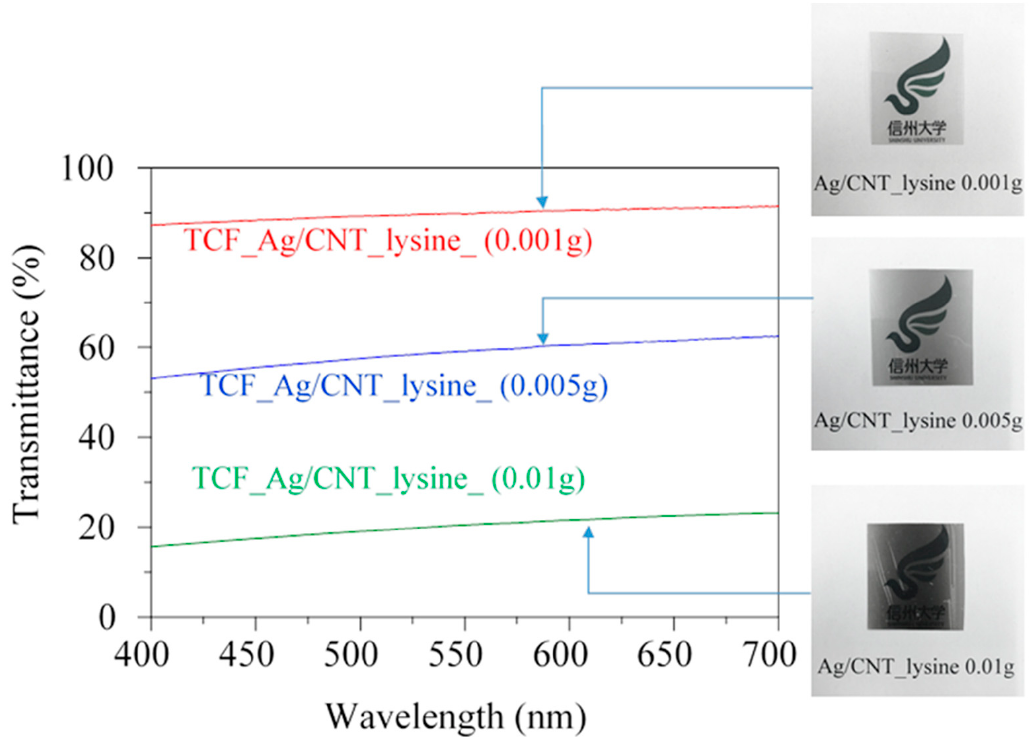
Figure 9. Relationship between the optical transmittance of AgNP/MWCNT films of different amounts and the wavelength.